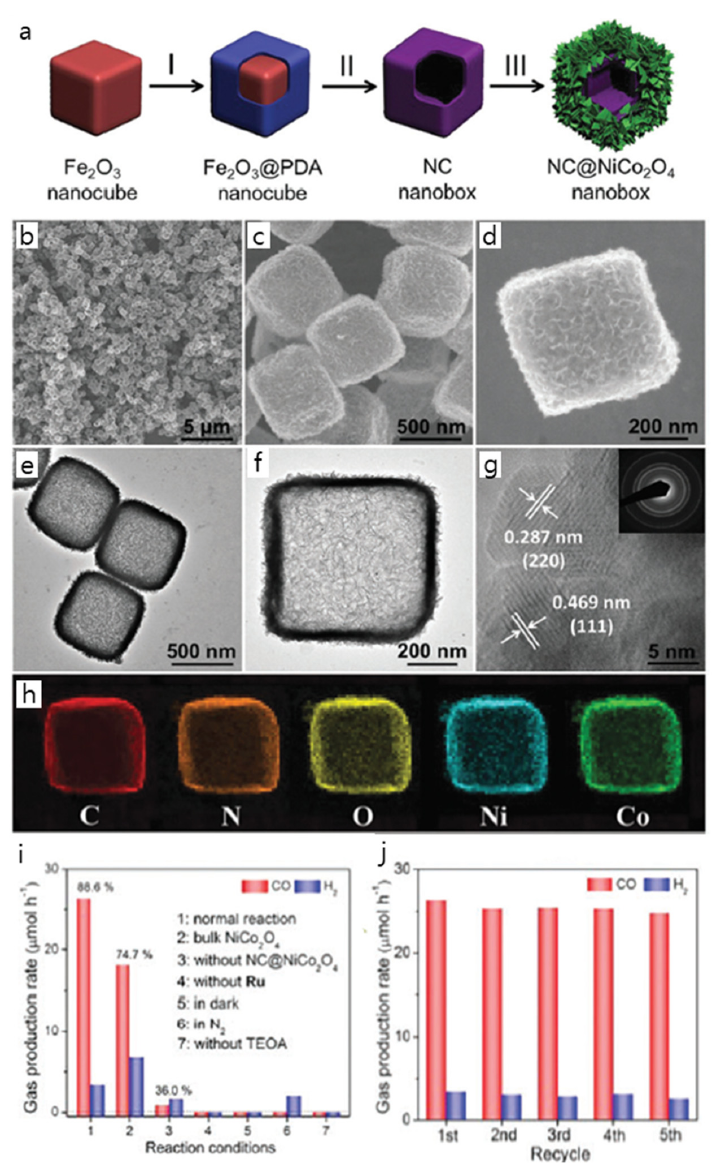
Figure 15. ( a ) Synthetic illustration of NC@NiCo 2 O 4 of hierarchical nanoboxes, ( b , d ) SEM images, Figure 15. (a) Synthetic illustration of NC@NiCo 2 O 4 of hierarchical nanoboxes, (b, d) SEM images, (e ‐ ( e , f ) TEM images, ( g ) HRTEM with SAED pattern, ( h ) EDX analysis with element mapping, ( i ) The f) TEM images, (g) HRTEM with SAED pattern, (h) EDX analysis with element mapping, (i) The result result of the CO 2 reduction test under various conditions and ( j ) stability test of CO and H 2 , reprinted with permission from